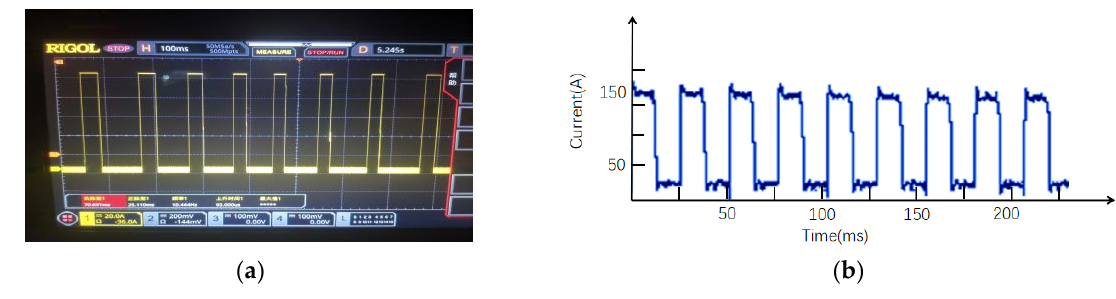
Figure 8. Current frequency. ( a ) Measurement. ( b ) Analysis.